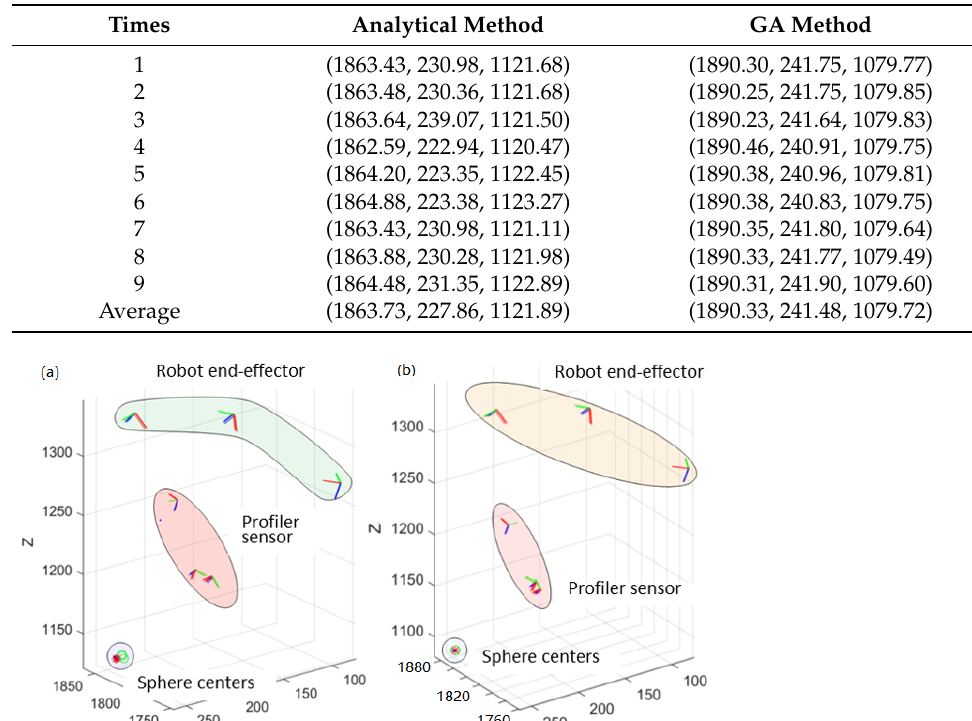
Table 1. Sphere center results.